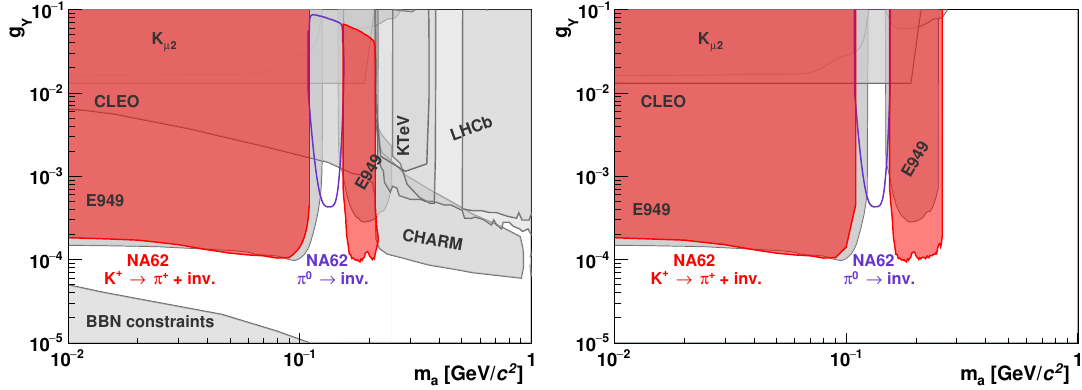
Figure 6 . Excluded regions of the parameter space ( m a , g Y ) for an ALP, a , of the BC10 model [1] decaying only (left) to visible particles and (right) invisibly. The exclusion bound from the present search for the decay K + → π + a is labelled as “ K + → π + + inv.” and is shaded in red. In the π 0 mass region the independent NA62 search for π 0 → invisible decays [25] provides constraints, shown in purple. Other bounds, shown in grey, are derived from the experiments E949 [23], K µ 2 [30], CLEO [31], CHARM [32], KTeV [33], LHCb [27, 28] and from Big Bang nucleosynthesis (BBN)